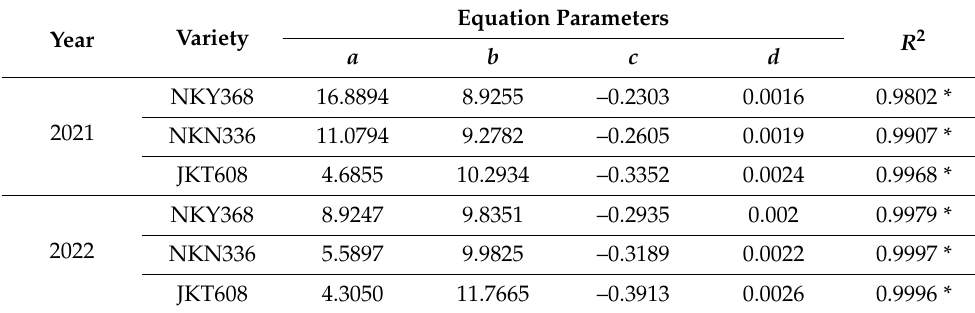
Table 3. Results of the parameter fitting for the LAI equation.